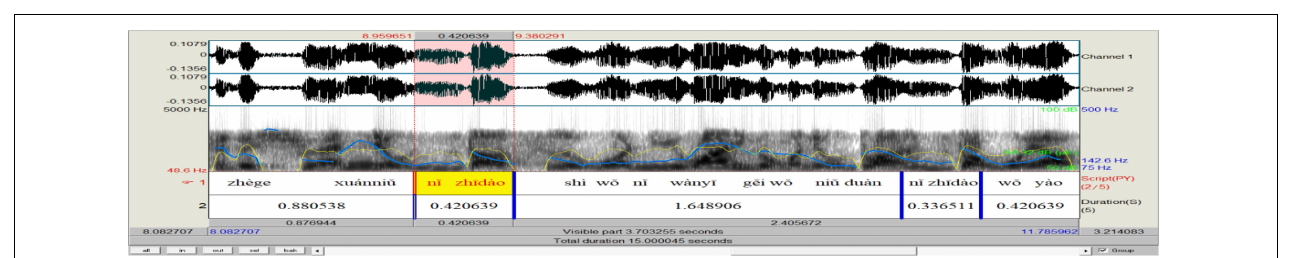
FIGURE 7 | Praat analysis of sentence-initial ni zhidao .